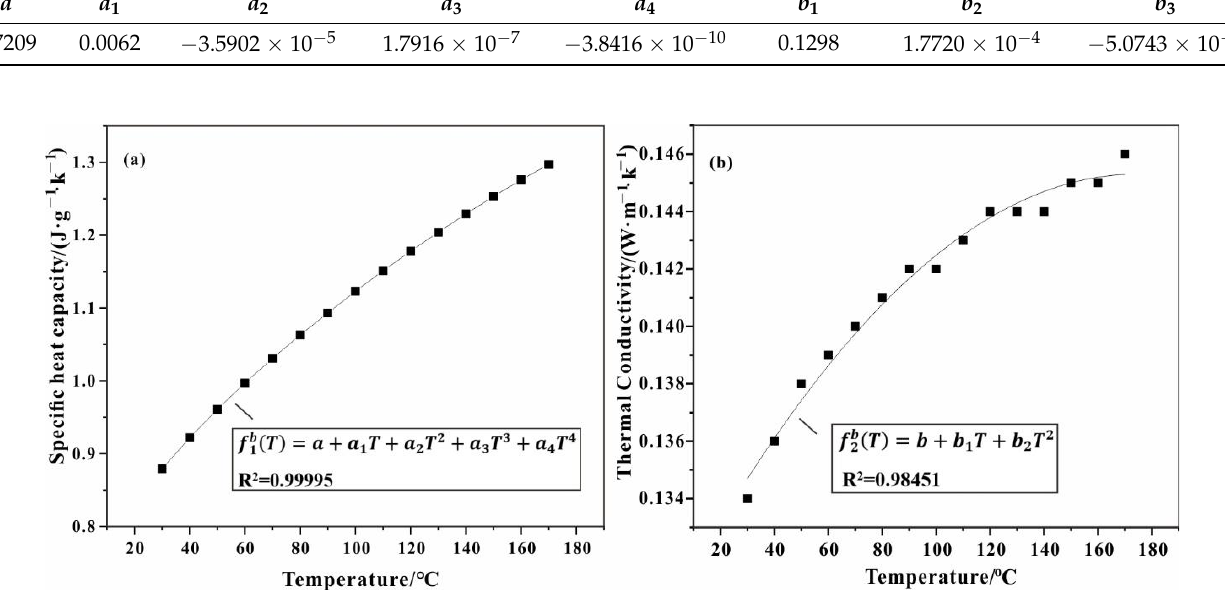
Table 1. Statistical data on basic thermophysical parameters of PS.